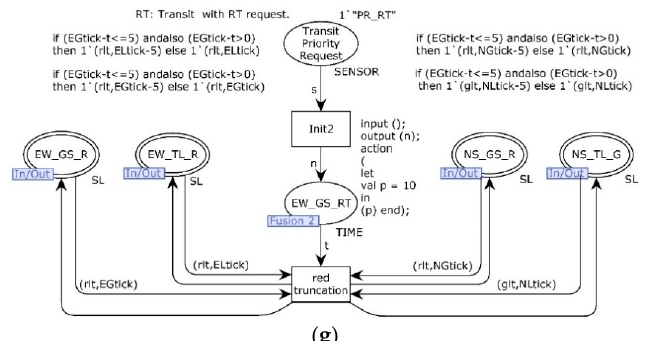
Figure 3. The Hierarchical Colored Petri nets (HCPN) model of transit signal priority control for public transit going straight through the crossing zone: ( a ) top-level signal control CPN model; ( b ) details of phase1 module; ( c ) details of phase2 module; ( d ) details of phase3 module; ( e ) details of phase4 module; ( f ) details of green extension module; ( g ) details of red truncation module. Table 2. Physical meaning of places and transitions in Figure 3.